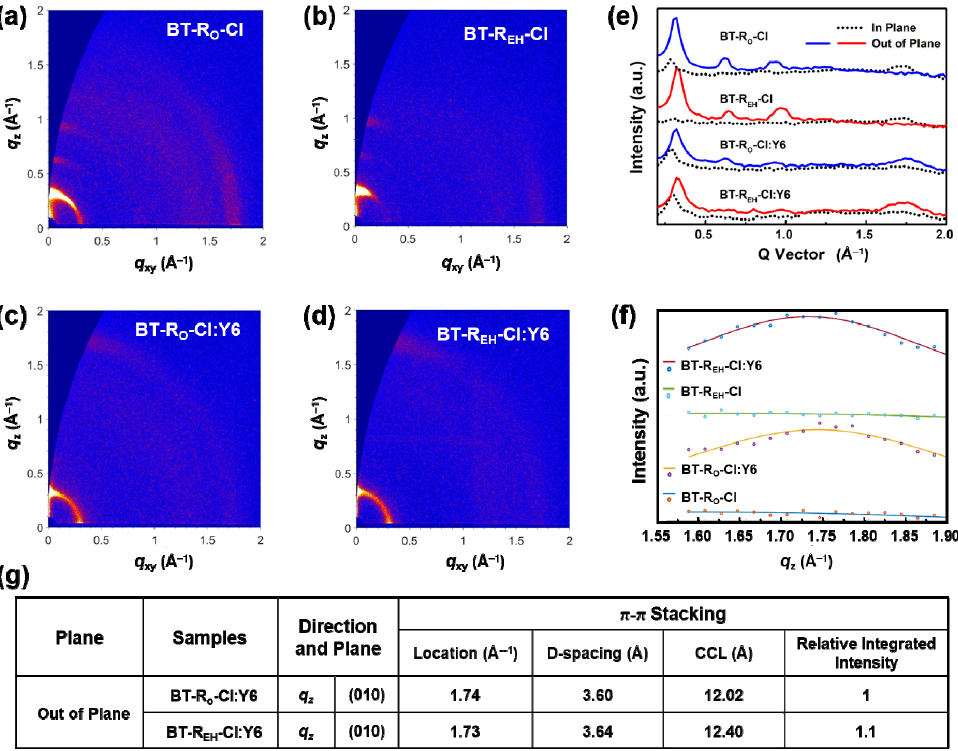
Figure 6. ( a – d ) GIWAXS patterns of pure and blended films; ( e ) in-plane (dotted lines) and out-of-plane (solid lines) line-cut profiles of the corresponding GIWAXS intensity profiles; ( f ) part of the intensity distribution and fitting curves corresponding to (010) diffractions in the q z direction; and ( g ) the analysis data of (010) diffractions in the q z direction.